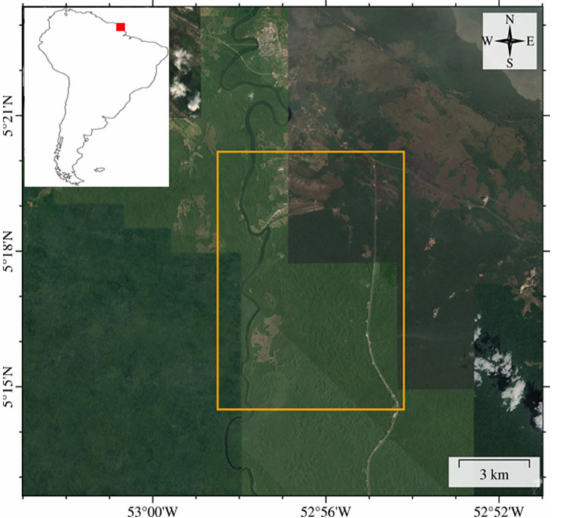
Figure 1. The geographic location of the study area. The yellow rectangle represents the footprint of the